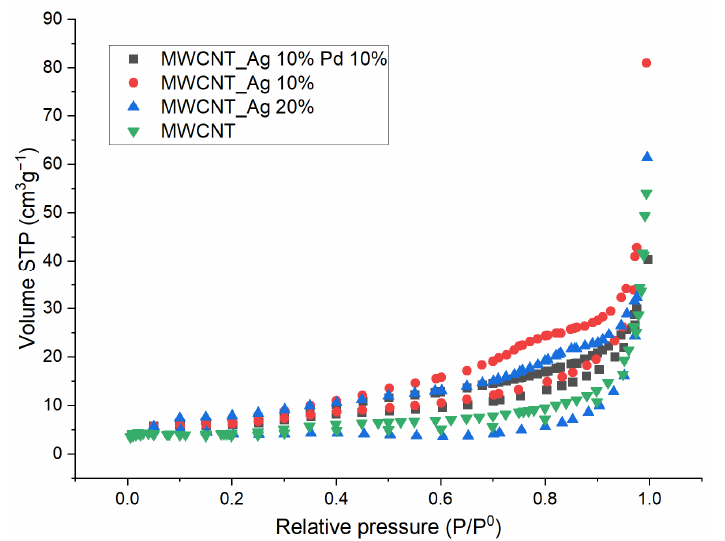
Figure 1. Isotherms of low-temperature adsorption–desorption of nitrogen on the investigated catalysts and carriers. Table 1. The textural characteristics of the supports and catalysts.